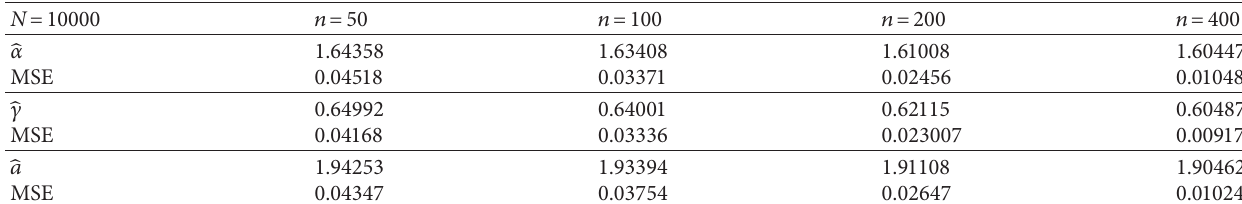
Table 4: Maximum likelihood estimates of the parameters ( α , c , a ) and their